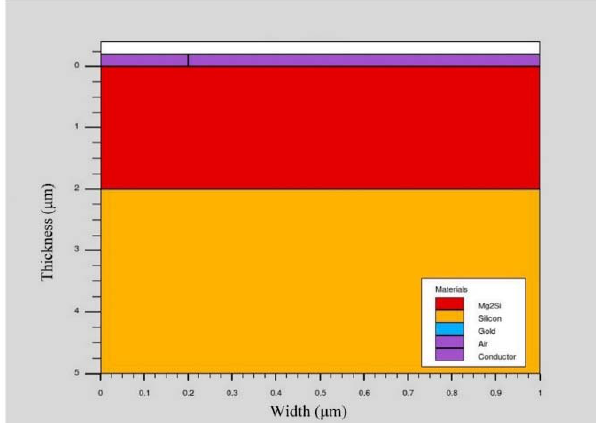
Figure 1. The cross section of the p-Mg 2 Si/n-Si heterojunction PD model.